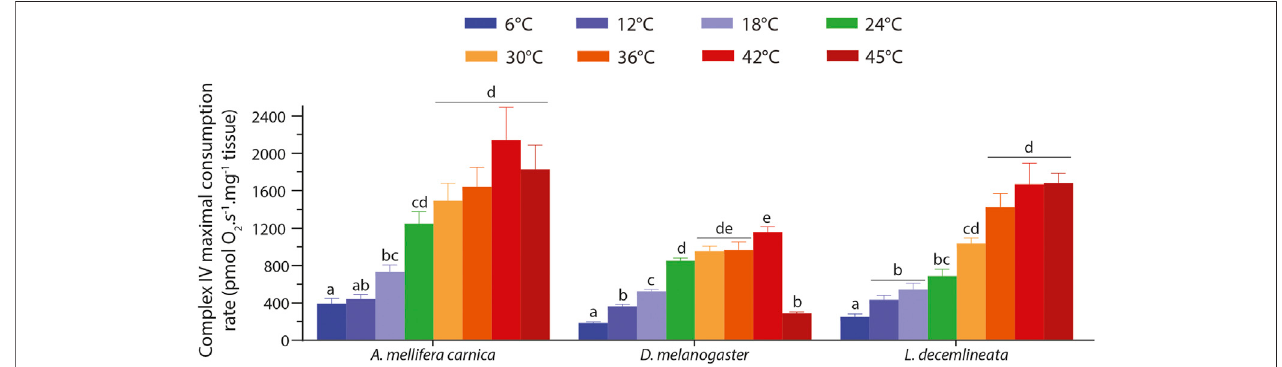
FIGURE4| ComplexIVmaximaloxygenconsumptionratemeasuredinpermeabilizedthoracesof A.melliferacarnica ( n =9 – 10), D.melanogaster ( n =5 – 10)and L. decemlineata ( n = 8 – 10). Complex IV maximal oxygen consumption rates were measured after inhibition of complexes I, II, and III and the addition of ascorbate and TMPD. This rate was corrected for TMPD auto-oxidation by further inhibiting complex IV with sodium azide. These rates are reported as mean ± s.e.m and were compared within species between assay temperatures using a one-way ANOVA followed by a HSD (Honest Signi fi cant Difference) Tukey ’ s test. Dissimilar letters indicate signi fi cant differences between Complex IV maximal oxygen consumption rates for each